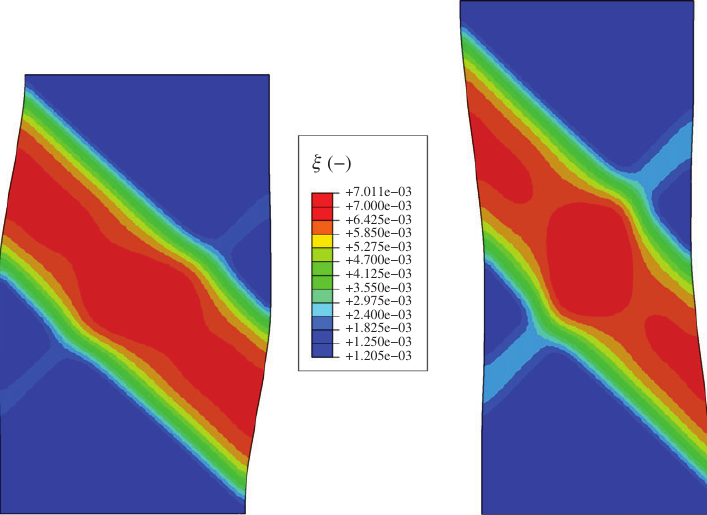
Figure 13 Sample S , tension-compression asymmetry: spatial distribution of free volume ξ at an applied strain | E 1 sive (left) and tensile (right) loading. The shear band angle under compression is Θ = 41 ° and under tension Θ = 46 °